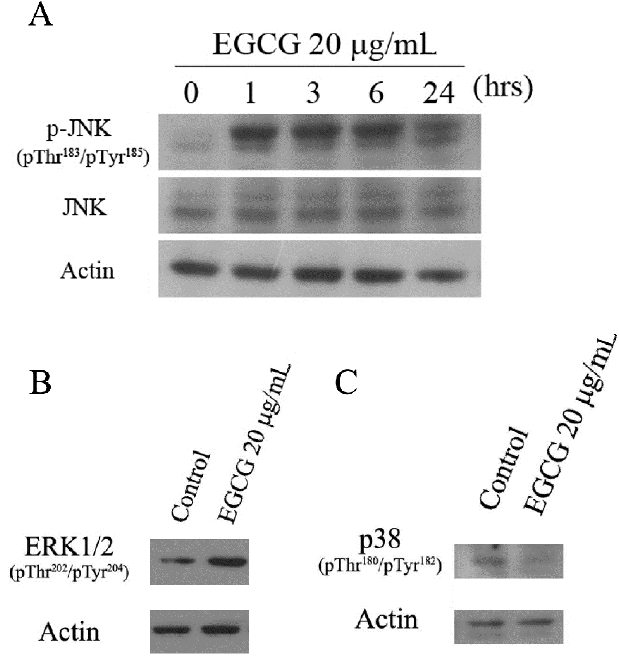
Figure 6. ( A ) Western blot analysis of JNK activation in EGCG-treated BCBL-1 cells. BCBL-1 cells were treated with 20 μ g/mL of EGCG for 1, 3, 6, and 24 h. The protein levels of JNK and phosphorylated forms of JNK were determined; ( B ) Western blot analysis of ERK activation in EGCG-treated BCBL-1 cells; ( C ) Western blot analysis of p38 inactivation in EGCG-treated BCBL-1 cells. BCBL-1 cells were treated with 20 μ g/mL of EGCG for 24 h. The protein levels of phosphorylated forms of ERK and p38 were determined. β -actin was used as the loading control.